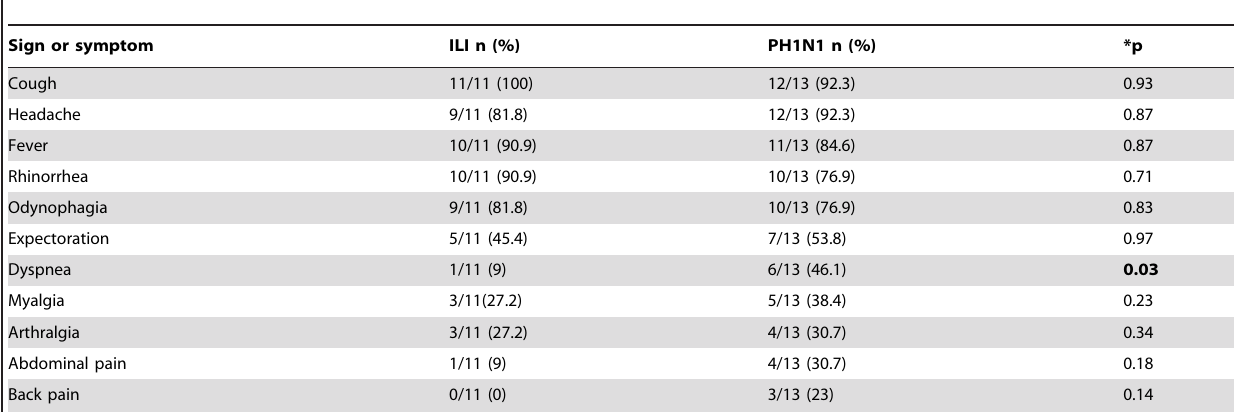
Table 2. Clinical manifestations in the ILI and PH1N1